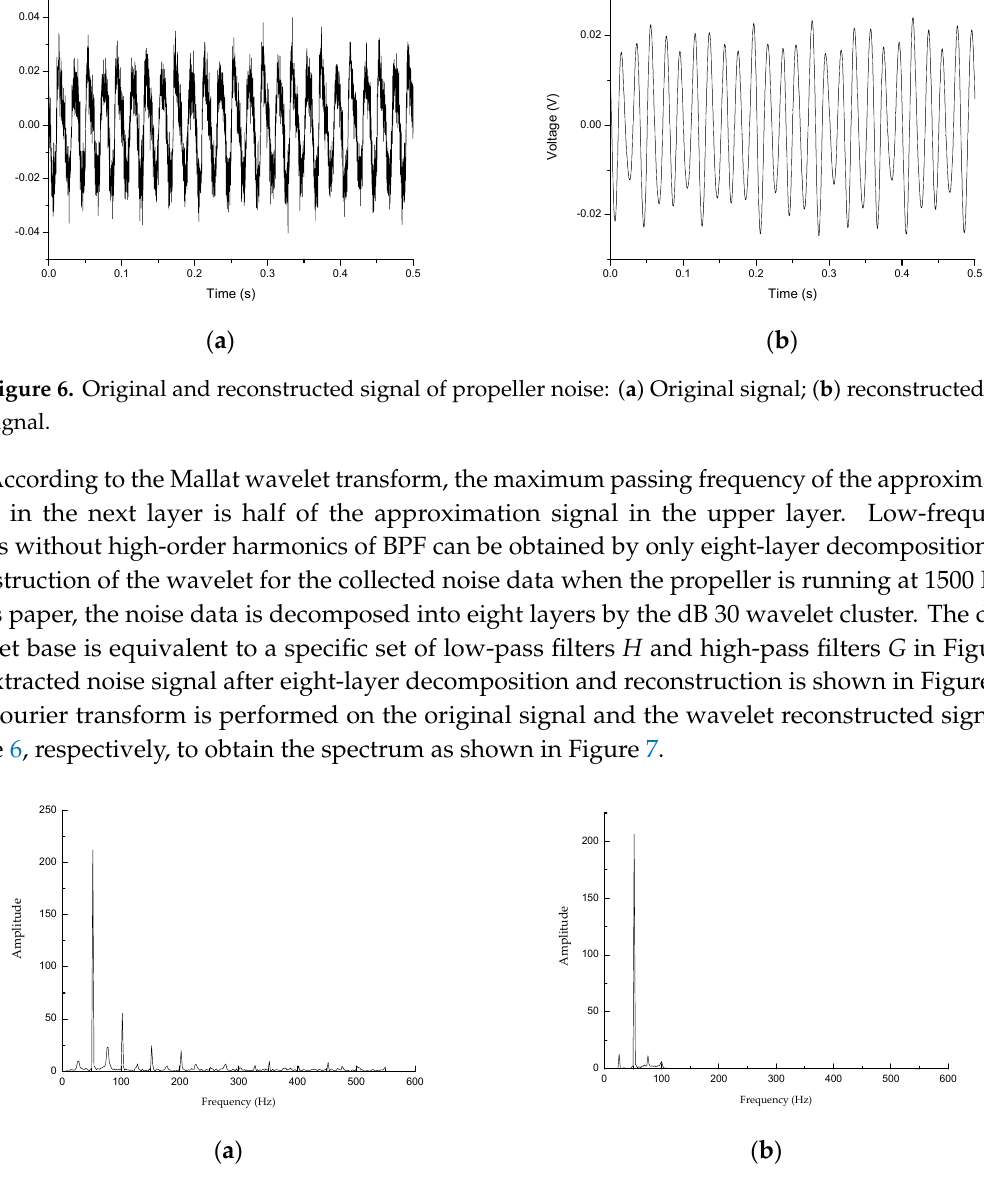
Figure 7. Signal spectrum: ( a ) Propeller noise signal spectrum; ( b ) Reconstructing signal spectrum.